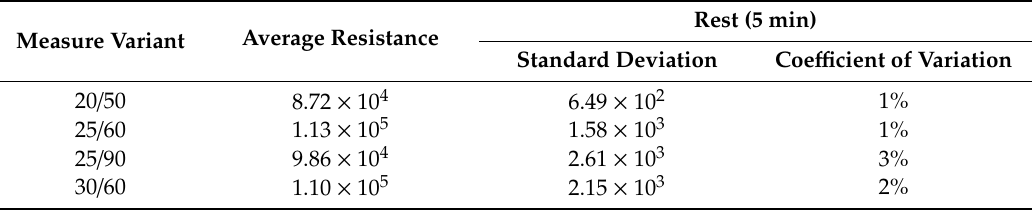
Table 2. Statistical data and variation coe ffi cients at rest.